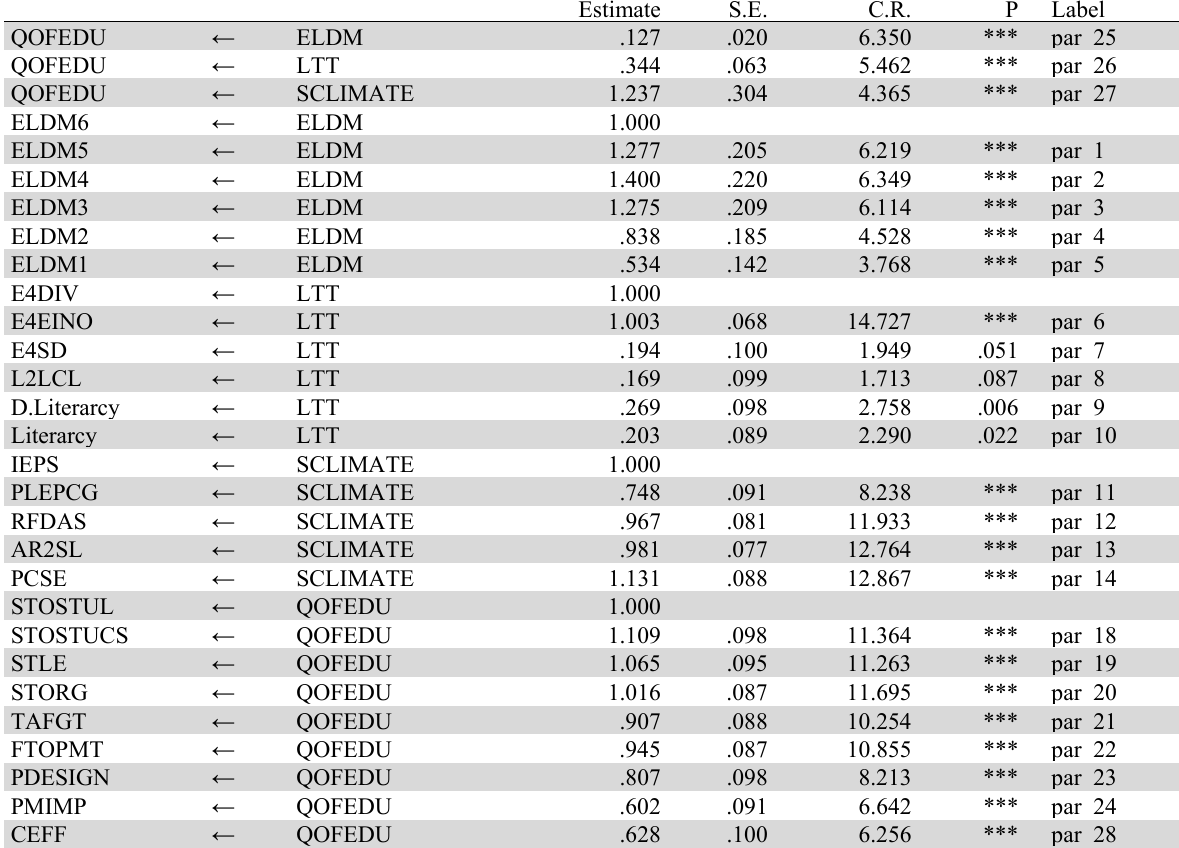
Regression Weights: (Group number 1 - Default model)